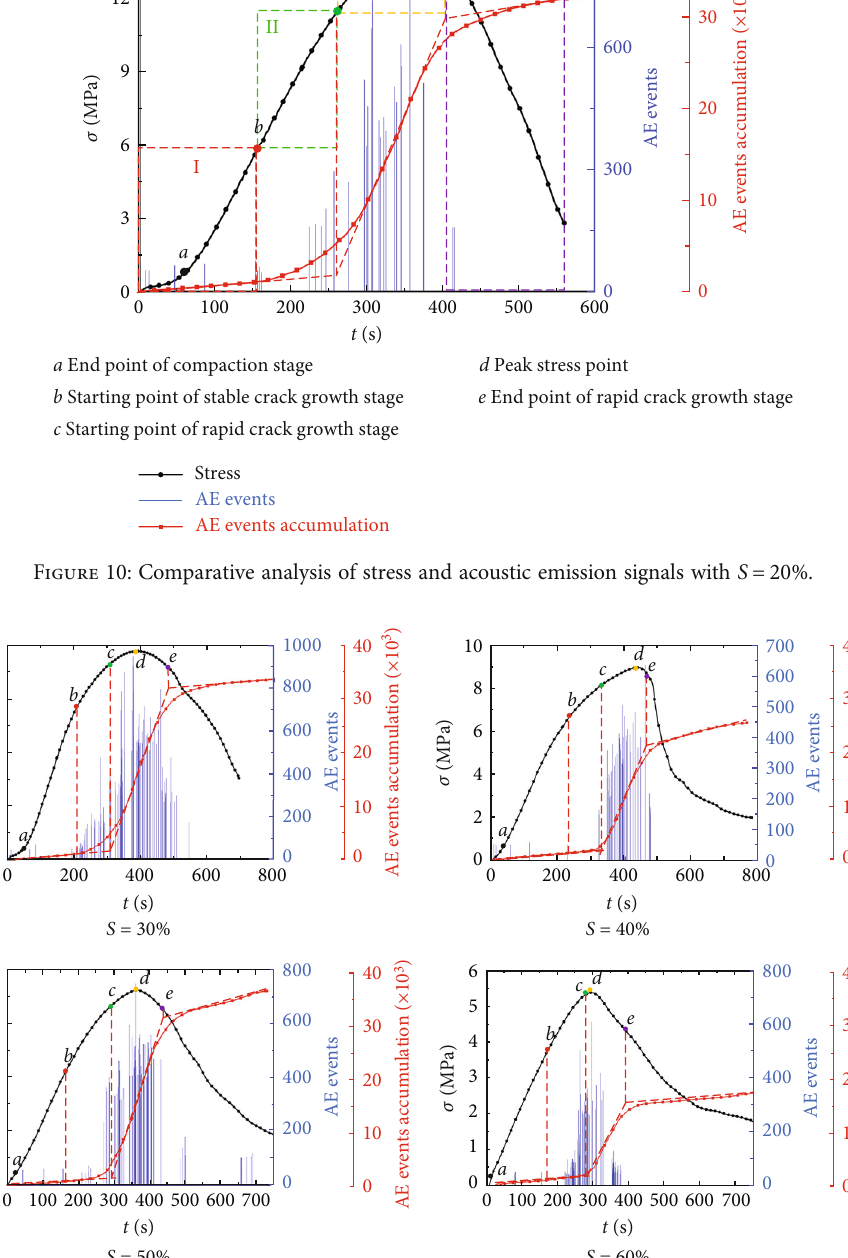
of clay minerals are observed. It can be found that when the percentage of clay minerals is high, the overall porosity is more signi fi cant, and the internal particles are more loosely distributed but more uniformly distributed. As the clay